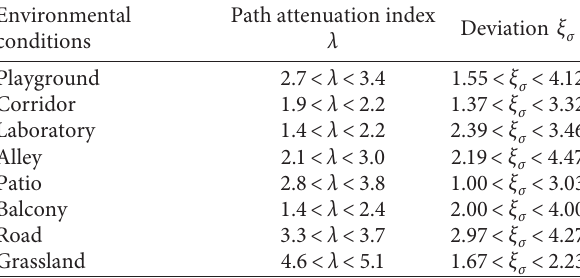
in different condition. σ